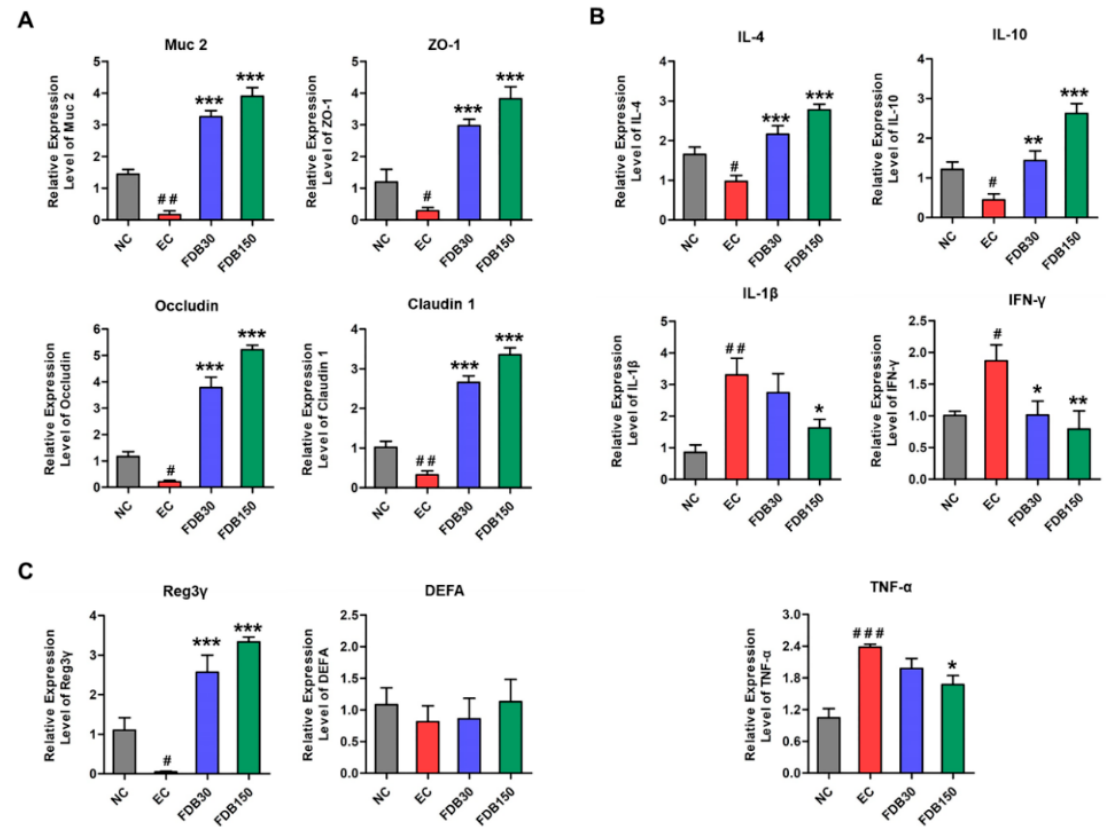
Figure 2. Effects of FDB on the mRNA expression of intestinal barrier protein, inflammatory cytokines, and antimicrobial peptide in the ileum. ( A ) Muc-2, ZO-1, Occludin, and Claudin 1; ( B ) IL-4, IL-10, IL-1 β , IFN- γ , and TNF- α ; ( C ) Reg3 γ and DEFA. # p < 0.05, # # p < 0.01, and # # # p < 0.001 vs. normal control (NC) group; * p < 0.05, ** p < 0.01, and *** p < 0.001 vs. exercise control (EC) group. FDB30: 30 mg/kg FDB group; FDB150: 150 mg/kg FDB group.